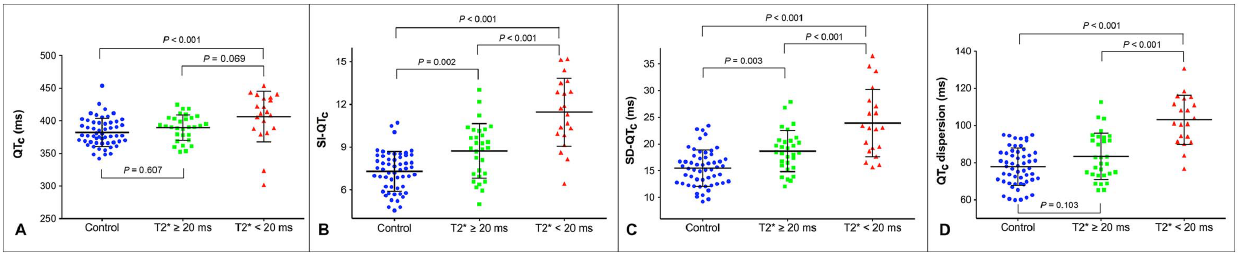
Figure 2. Comparisons of mean QT c interval (A), SI-QT c (B), SD-QT c (C), and QT c dispersion (D) in patients and controls. Patients were further divided into those with normal cardiac T2* value ( $ 20 ms) and those with abnormal cardiac T2* value ( , 20 ms). QT c =corrected QT interval; SI-QT c =smooth index of corrected QT intervals; SD-QT c =standard deviation of corrected QT intervals.